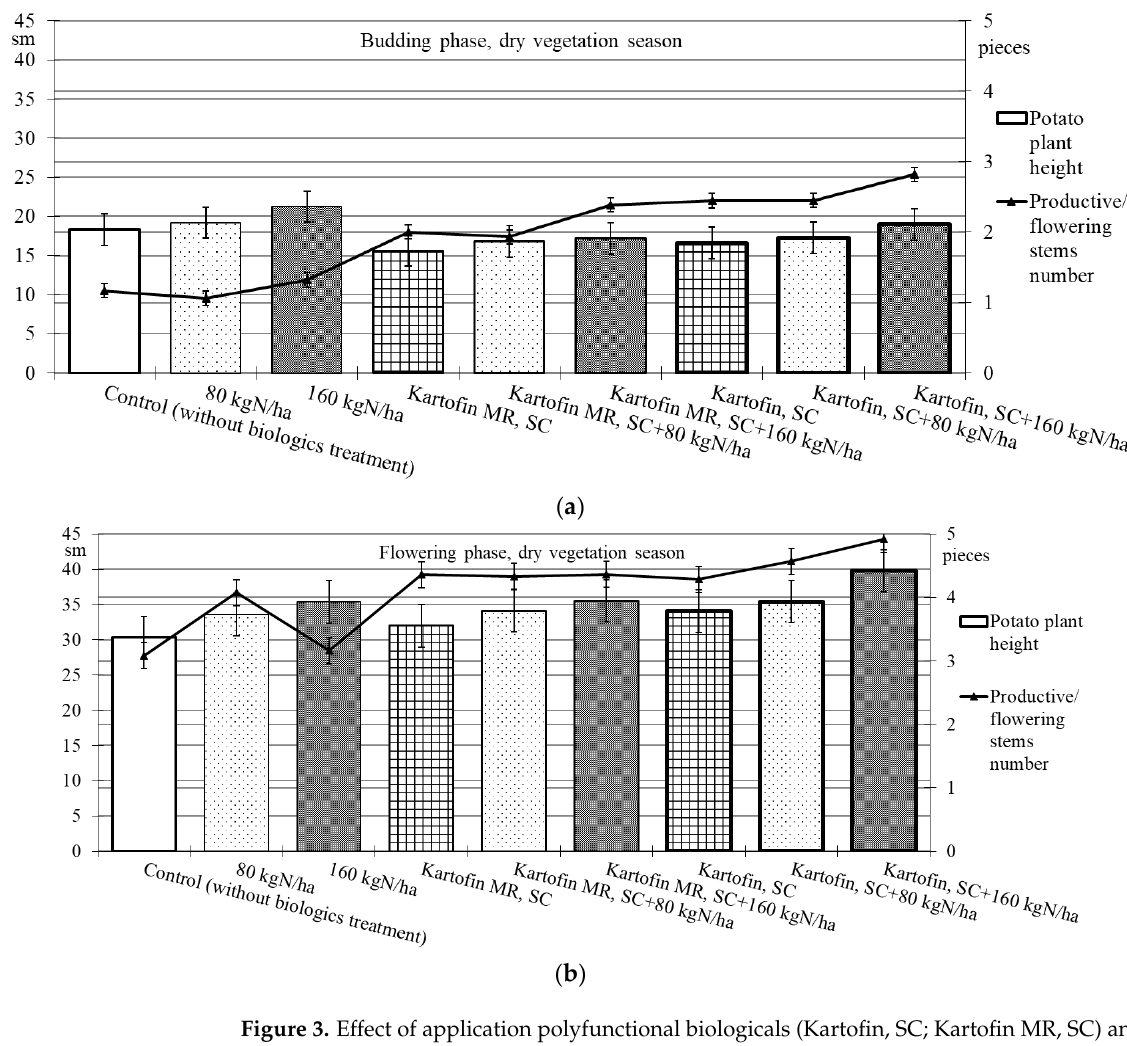
Figure 3. Effect of application polyfunctional biologicals (Kartofin, SC; Kartofin MR, SC) and organic fertilizer BIAGUM in doses 80; 160 kg N ha − 1 on biometric indicators (plant height — sm; productive stems number — pieces) of the potato plants ’ development in organic growing during dry vegetative season: ( a ) — in budding phase; ( b ) — in flowering phase.